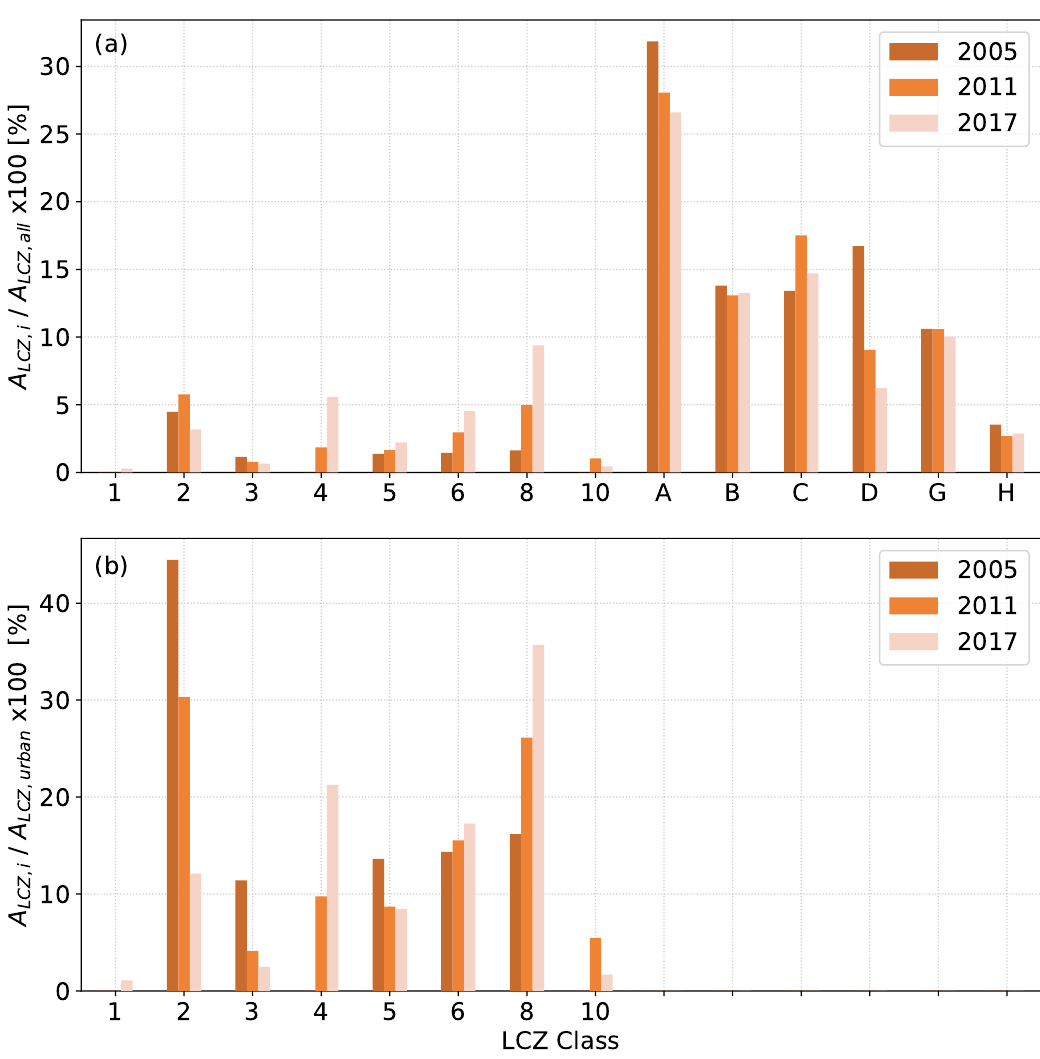
Figure 6. LCZ histograms for all years presenting the corresponding surface area (A) of each LCZ (A LCZ , i ) as the percentage of ( a ) the total surface area (A LCZ , all ) and ( b ) the total urban area ( LCZ , urban